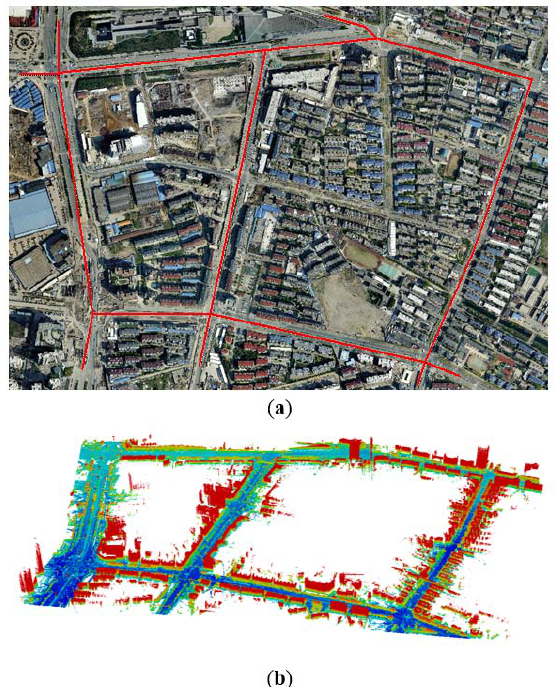
Figure 9. Experimental area. ( a ) Aerial orthophotos of the experimental area, red line denotes the SSW mobile mapping system’s driving route; ( b ) Raw VLS data of the experimental